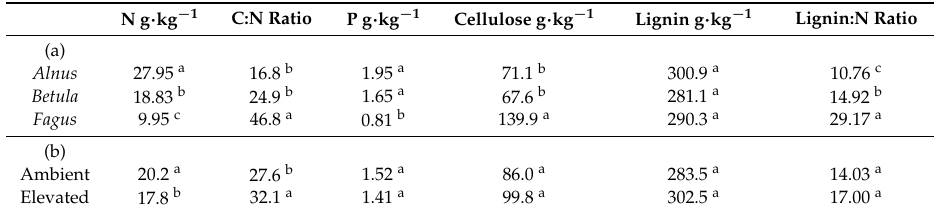
Table 1. Effect of ( a ) litter species and ( b ) CO 2 regime on the chemical composition of the litter used in the mesocosm experiment.